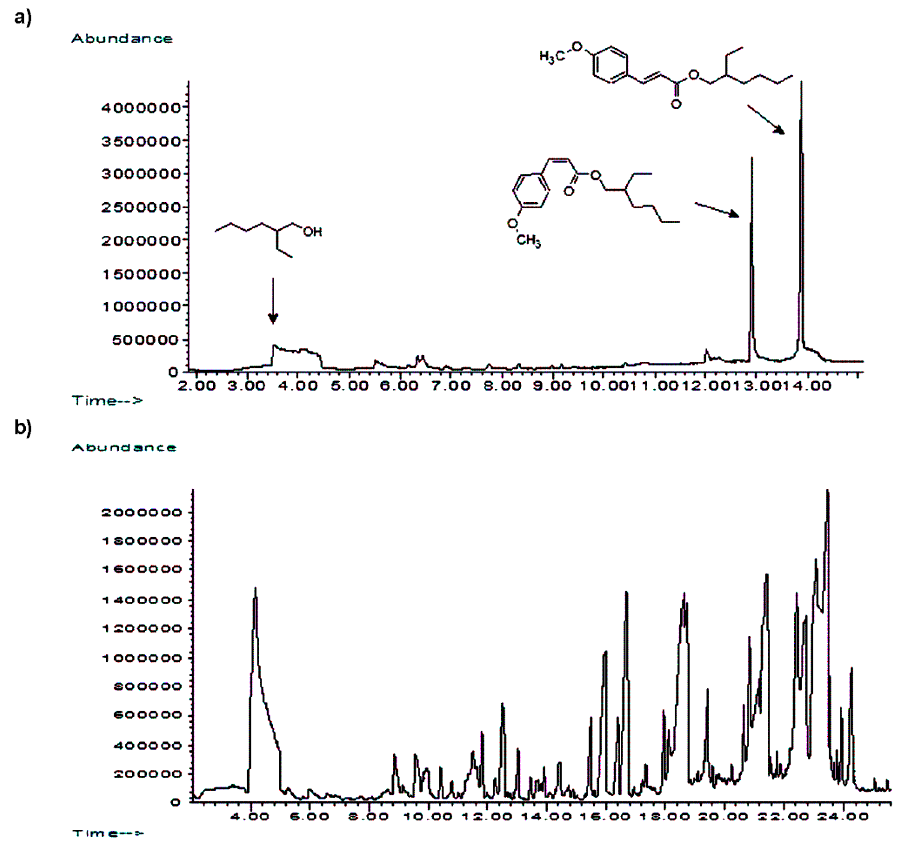
Figure 3. Gas chromatograms of the products of EHMC conversion in: a) EHMC/H